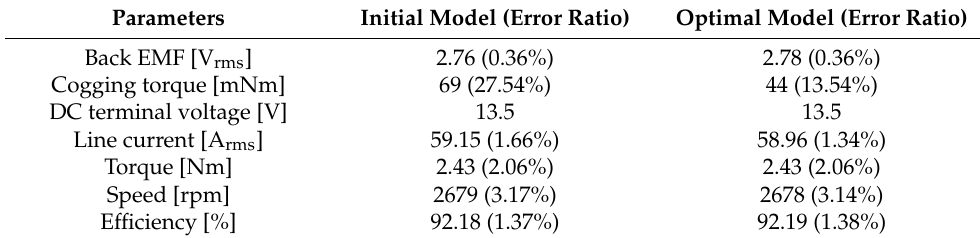
Table 9. Electromagnetic parameter analysis results in the double-pole